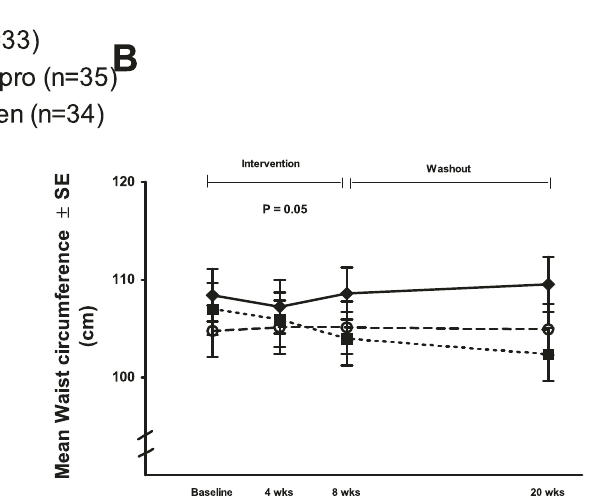
interaction effect during the 8-week intervention. Two-tailed P -values <0.05 were consideredstatisticallysigni fi cant(multiplecomparisonsnotconsidered).Number of participants: Glar n =33; Glar/Lispro n =35; Glar/Exen n =34.